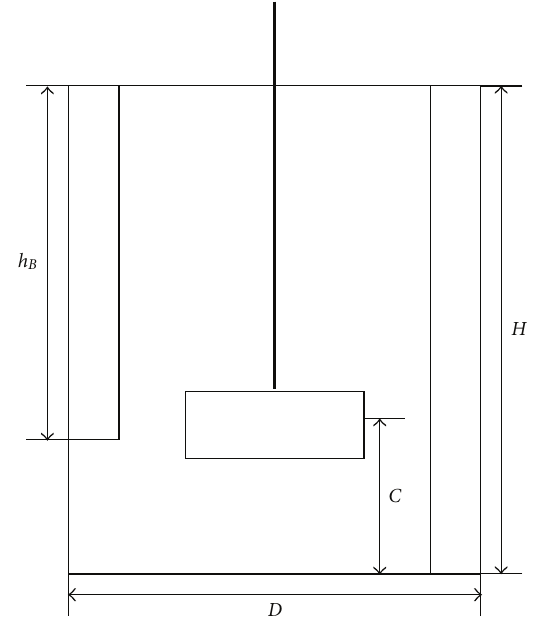
Figure 3: Geometry of mixing